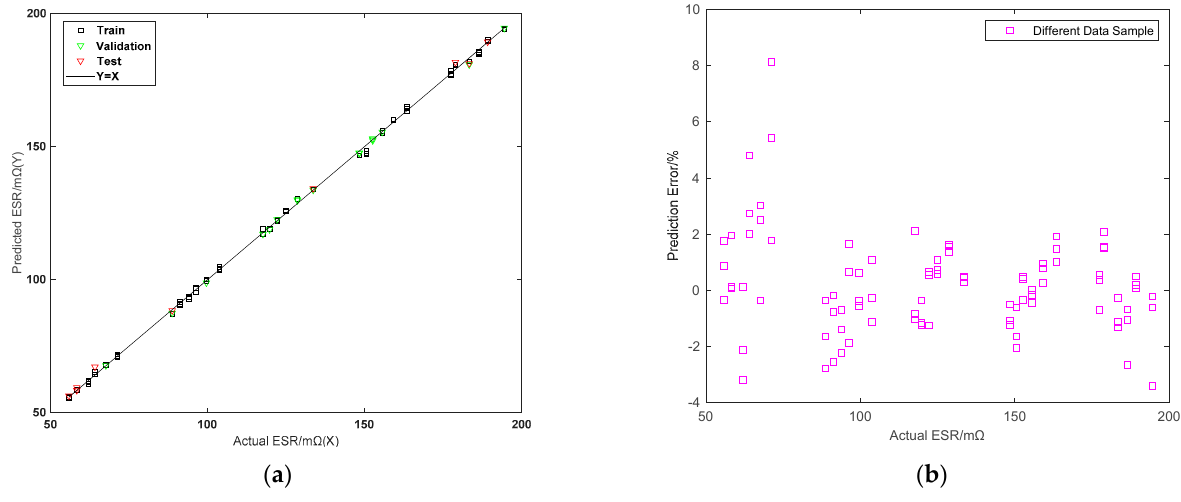
Figure 11. ESR estimation results under experiments by ANN when N ESR = 10 ( a ) a best fitting showing train, test and validation results; ( b ) cross validation showing PEs for 10 fittings under 10 random data divisions.